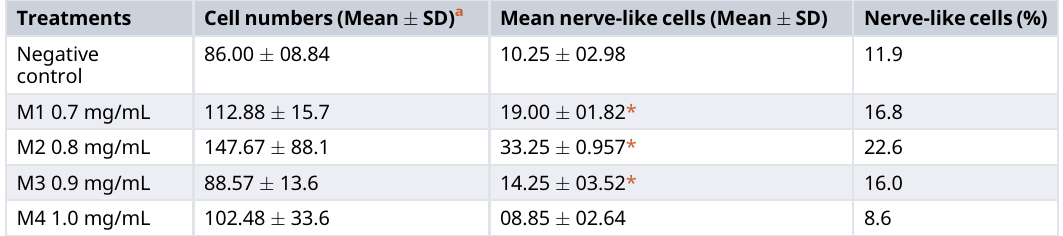
Table 2. The total number of nerve-like-cells in DMEM medium with different doses of methanol extract of C. odorata. Treatments Cell numbers (Mean (cid:3) SD) a Mean nerve-like cells (Mean (cid:3)